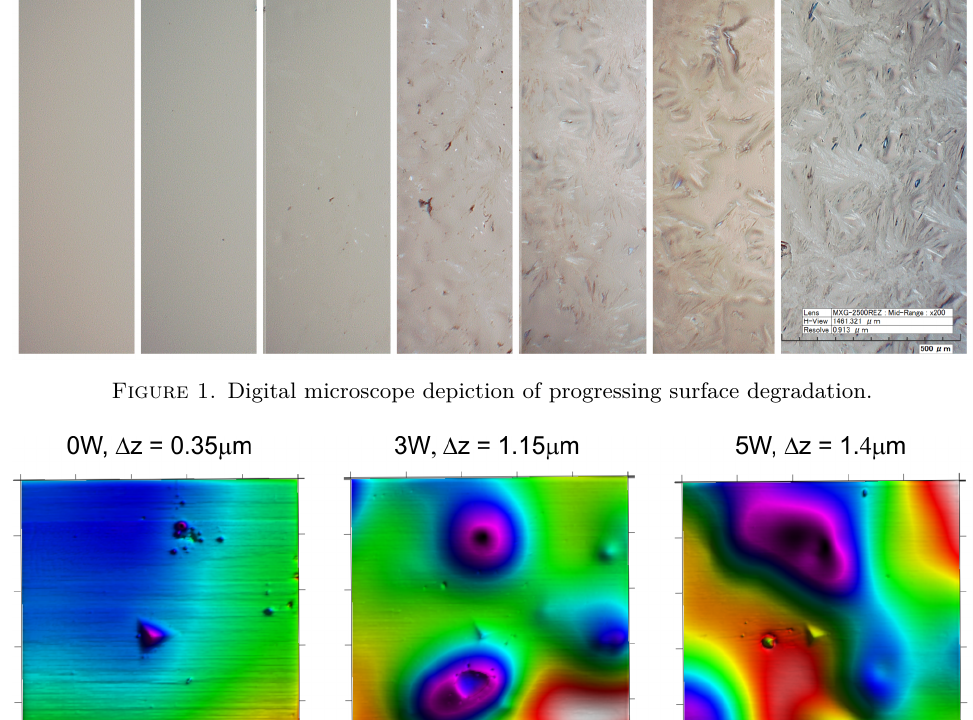
quite general access includes a possibility of reflection of incidence ray out of incidence plane. Reflected radiation is completely described with bidirectional reflectance distribution function (BRDF)[10]